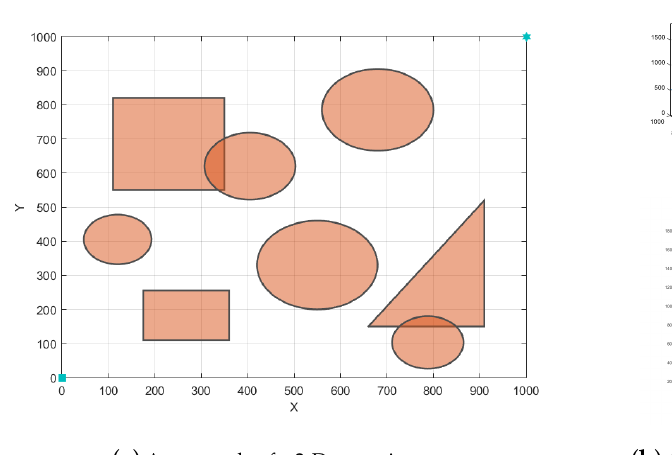
( b ) Graphical visualization of the cost function for the 2-D scenario on the left. Figure 3. Example of a 2-D scenario and visualization of its cost function ( Dim ( X i ) =